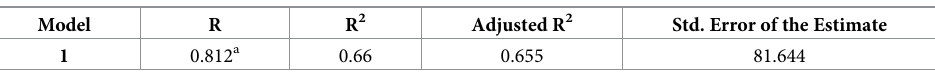
Table 7. Model summary.